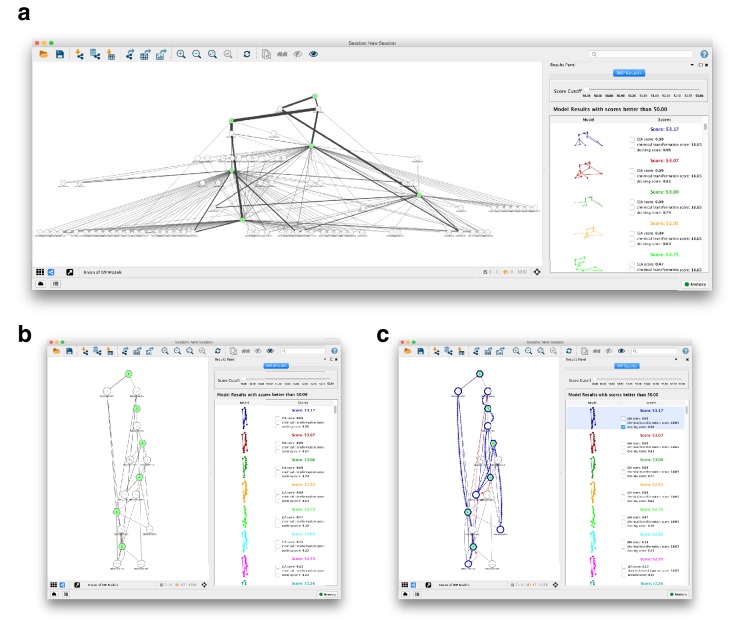
NetIMP cytoscape application for pathway model visualization.(A) Cytoscape app loads in good-scoring pathway models and displays them as a network built from the union of edges present in the ensemble of models. The automated yFiles hierarchic layout was applied to the network. The thickness of the edge represents the frequency that the edge appears in the ensemble. (B) The slider in the Results Panel can adjust the score cutoff for the models included in the network. In this view, the automated yFiles hierarchic layout is reapplied and singleton nodes are hidden for clarity. (C) An individual model is selected in the Results Panel, and the nodes and edges in the individual model are highlighted in the model’s unique color (in blue, here) on the network. The restraints are represented by the hatched edges connecting nodes corresponding to the restraints. Restraints that are violated in the mode are colored red.